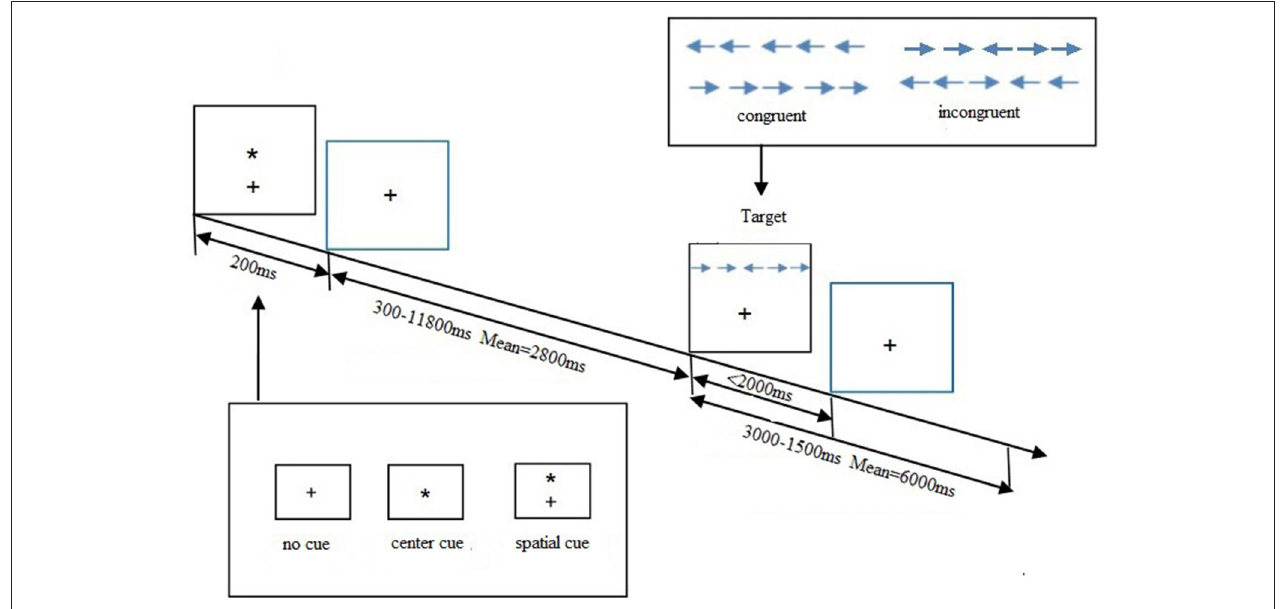
FIGURE 1 | Attention network test (ANT) schematic showing the time and different conditions for each trial. A trial starts via presenting one cue condition for 200ms. A variable delay period of 300–11,800ms elapses before one target condition is displayed. The target disappears after 2,000ms had elapsed or until they made a response. From the moment, the target appears the trial continues for a variable delay period of 3,000–15,000ms.